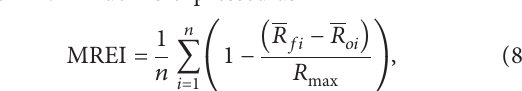
Table 3: Contingency table